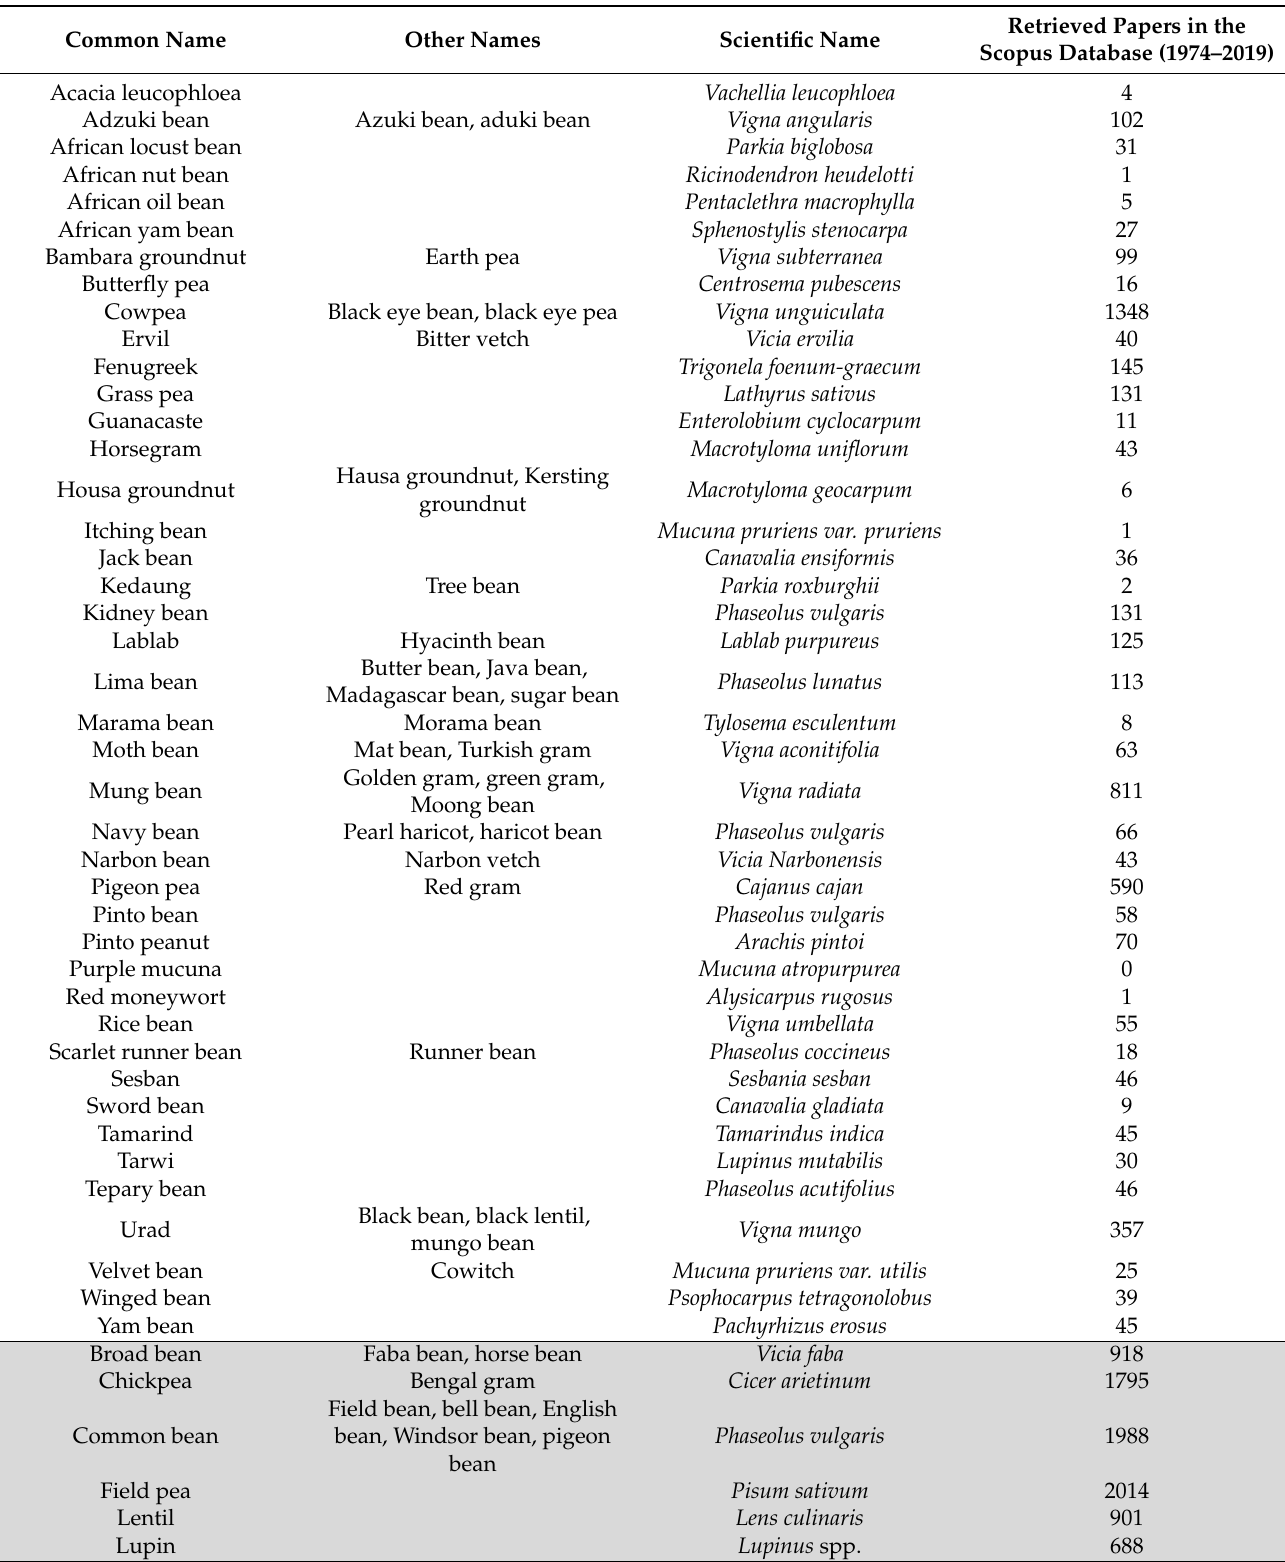
Table 2. Retrieved papers in the Scopus database for the period 1974–2019 for a sample of cultivated minor and major pulses (in grey) with a protein seed content above 20%, individual researches. In grey, a comparison with the same search was repeated for major